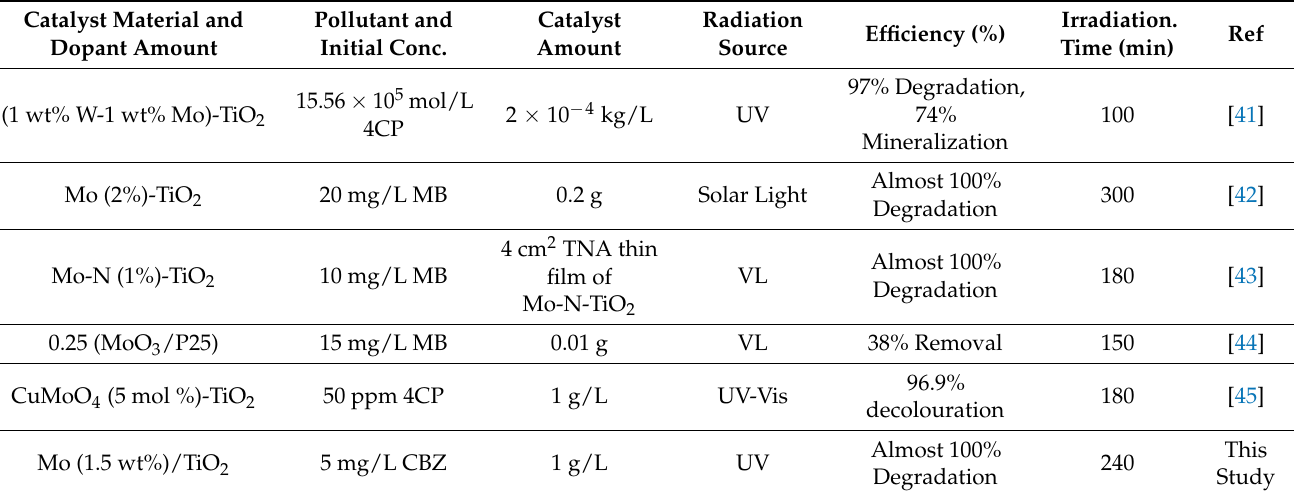
Table 3. Comparative photocatalytic activity performance summary of the few highlighted Mo containing modified photocatalyst materials and their operating conditions with respect to the present study